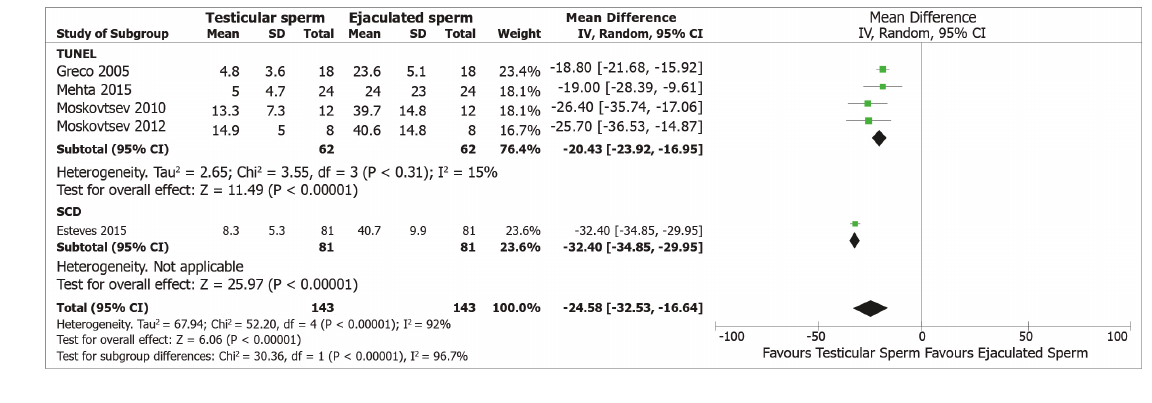
cI= confidence interval; Iv= inverse variance. Adapted with permission from Esteves et al.